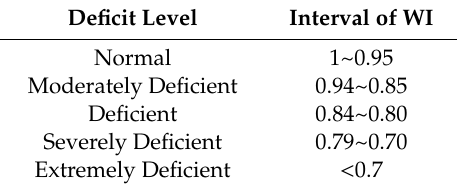
Table 2. The classification of water-use Index (The standard of Taiwan Water Corporation). Deficit Level Interval of